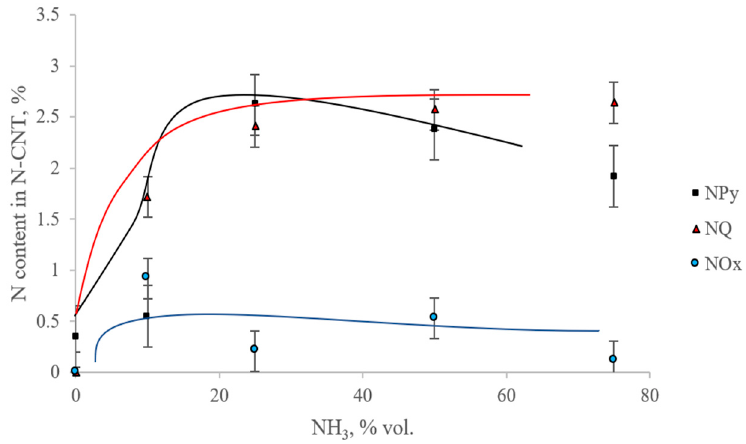
Figure 4. Dependence of the content of various forms of nitrogen on the content of NH 3 in the mix- ture.